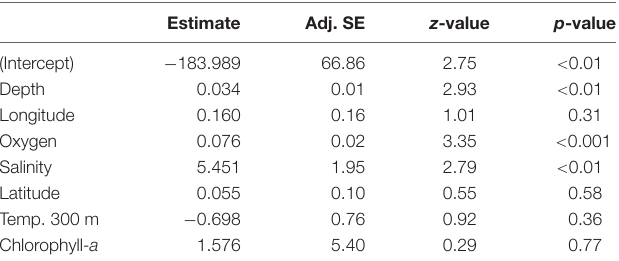
TABLE 3 | Results of the final GLM fit generated from the full average of the best model subsets to explain changes in echinoderm taxa richness. Adj.